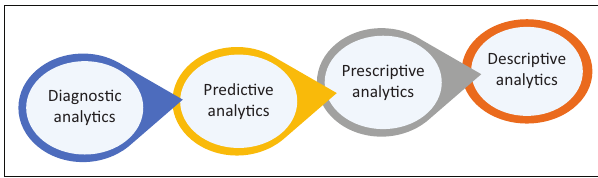
FIGURE 4: Types of Big Data Analytics.